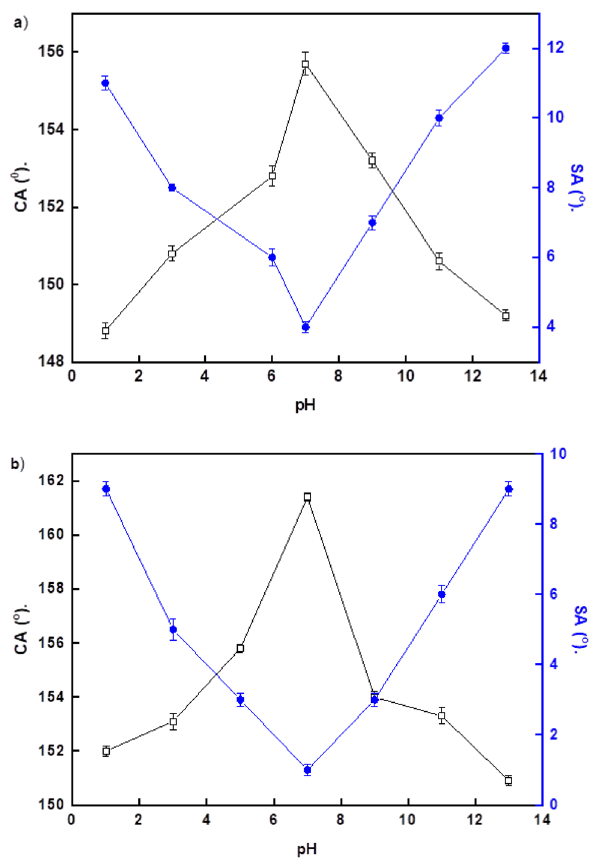
Figure 5. Variation of water droplets pH and their CAs and SAs on the steel coated by ( a ) Ni-SA coating and ( b ) Ni-G-SA coating.